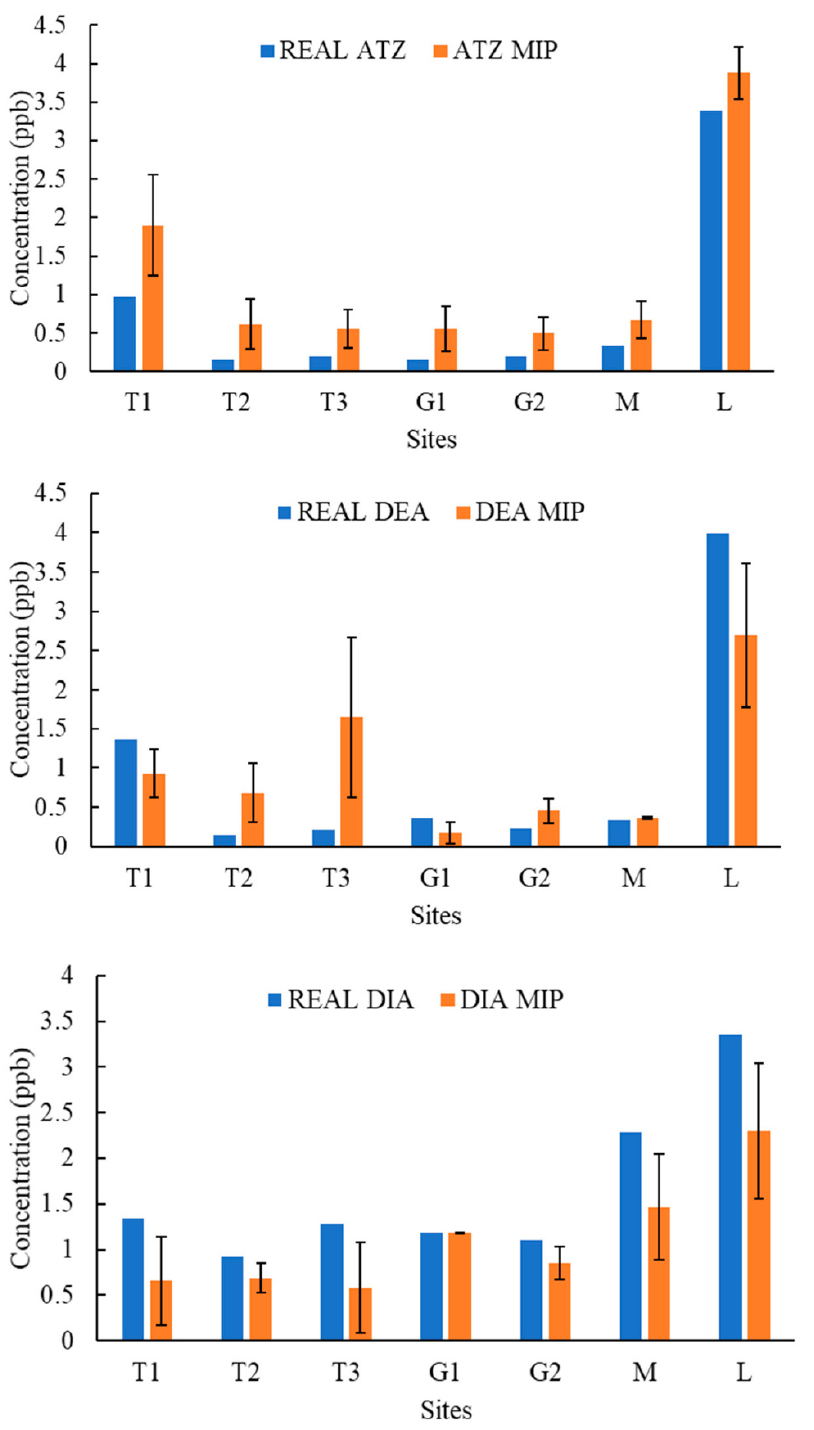
Figure 9. Average response of MIPs to ATZ, DEA, and DIA compared to real concentrations validated by LCMS/MS for samples of 14 March 2021.